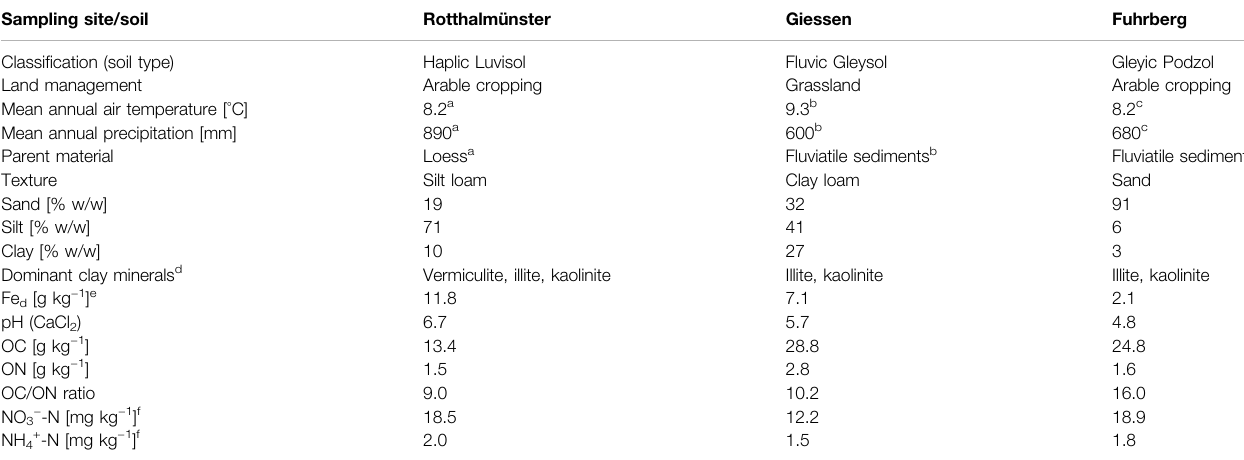
TABLE 1 | Basic characteristics of sampling sites and soils used for incubation experiments. Sampling